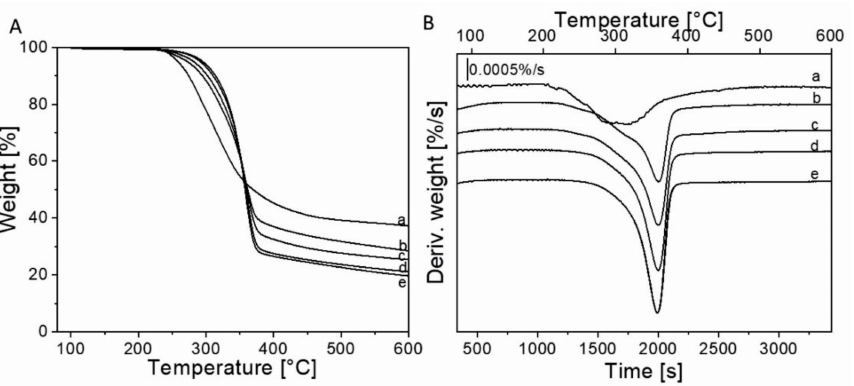
Figure 8. TG curves of samples ( A ) and their first derivatives ( B ) at 150 ◦ C: ( a ) 100% hydrolyzed wool; ( b ) 50%-50% kraft pulp/hydrolyzed wool; ( c ) 70%-30% kraft pulp/hydrolyzed wool; ( d ) 90%-10% kraft pulp/hydrolyzed; and finally ( e ) 100% kraft